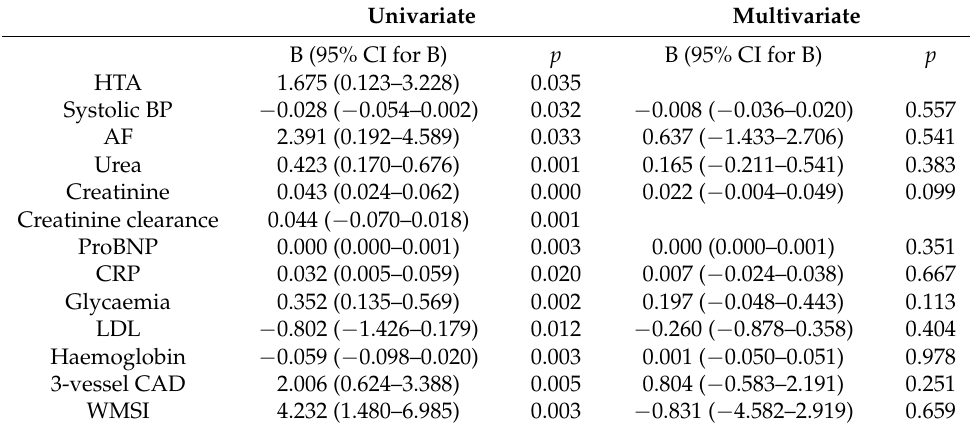
Table 4. Univariate and multivariate regression analysis demonstrating the relationship between baseline characteristics and galectin-3 concentration on day 1 for the entire population.